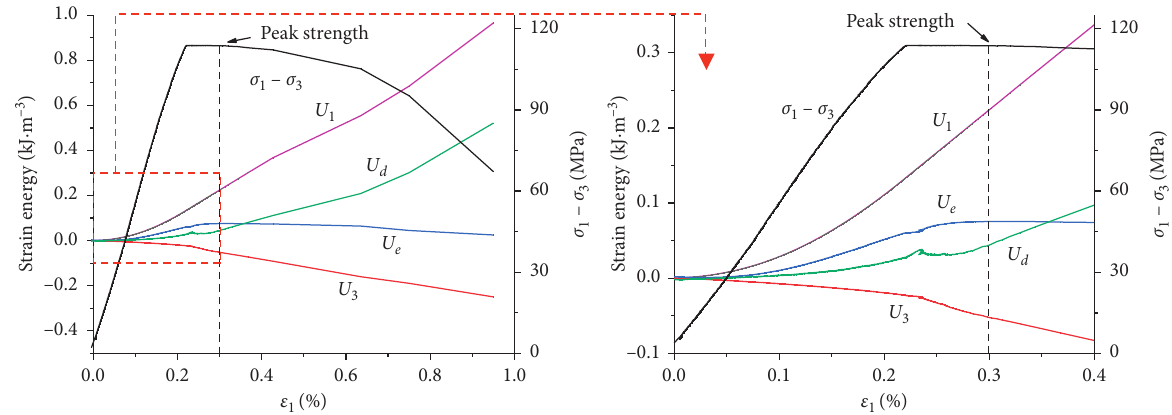
Figure 12: Typical strain energy curves from unloading tests (sample